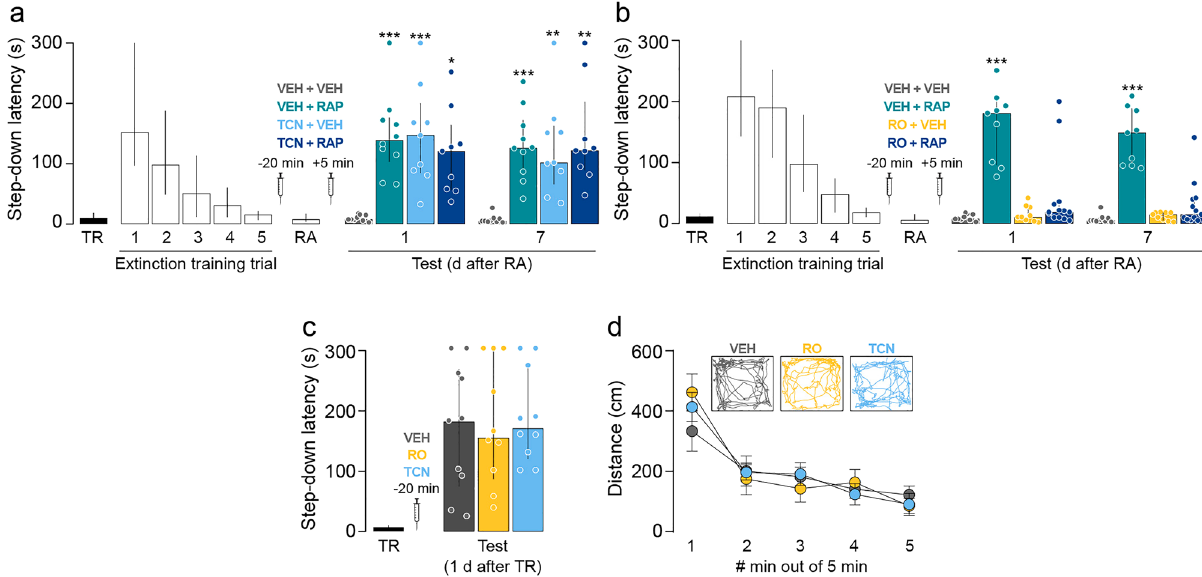
Figure 4. GluN2B-NMDARs are required for SDIA extinction memory destabilization. ( a ) Animals were trained in SDIA (TR; 0.4 mA/2 s) and, beginning 24 h later, they were submitted to one daily extinction training trial for 5 consecutive days. One day after the last extinction training trial, animals received bilateral intra-CA1 infusions of vehicle (VEH; 0.1% DMSO in saline) or the GluN2A-containing NMDAR antagonist TCN201 (TCN; 0.05 µg/side), and 20 min later, SDIA extinction memory was reactivated (RA). Five minutes after RA, rats received bilateral intra-dorsal CA1 infusions of VEH or rapamycin (RAP; 0.02 µg/side), an inhibitor of mammalian target of RAP (mTOR). Retention was assessed 1 day and 7 days later (Test). ( b ) Animals were treated as in A except that 20 min before RA they received bilateral intra-CA1 infusions of VEH or the GluN2B-containing NMDAR antagonist RO25-6981 (RO; 2.5 µg/side). ( c ) Animals trained in SDIA received bilateral intra-CA1 infusions of VEH, RO or TCN one day post-training and, 20 min later, were submitted to a SDIA memory retention test. ( d ) Animals received bilateral intra-dorsal CA1 infusions of VEH, TCN or RO and 20 min later were submitted to a 5 min-long open field arena exploration session to determine locomotor activity. Representative traces show locomotor activity from rats that received VEH, TCN or RO. Data are expressed as median ± IQR or mean ± SEM. (*) p < 0.05, (**) p < 0.01, (***) p < 0.001 versus VEH in Dunn’s multiple comparisons after Kruskal–Wallis test; n = 9–13 animals per